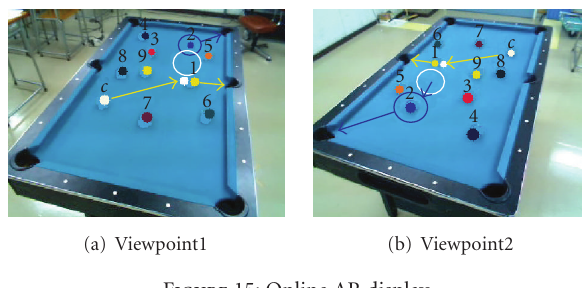
Figure 15: Online AR display.